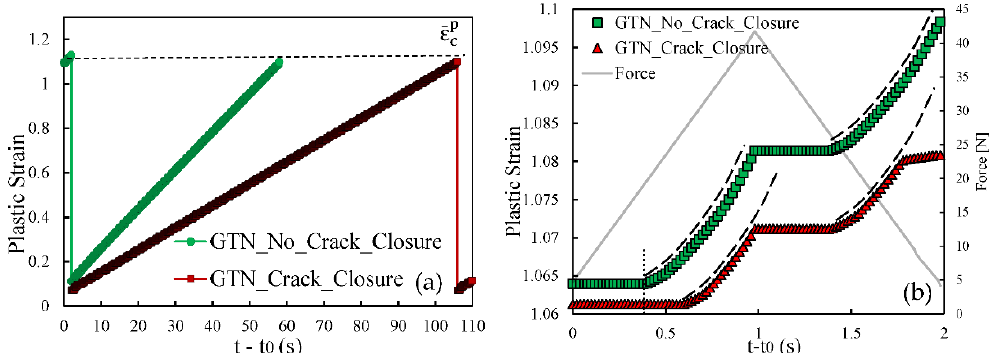
Figure 9. Effect of crack closure on plastic strain evolution, for a 0 = 11.5 mm. ( a ) Period between the 25th and the 26th crack propagations. ( b ) A single load cycle, before the 26th crack propagation.